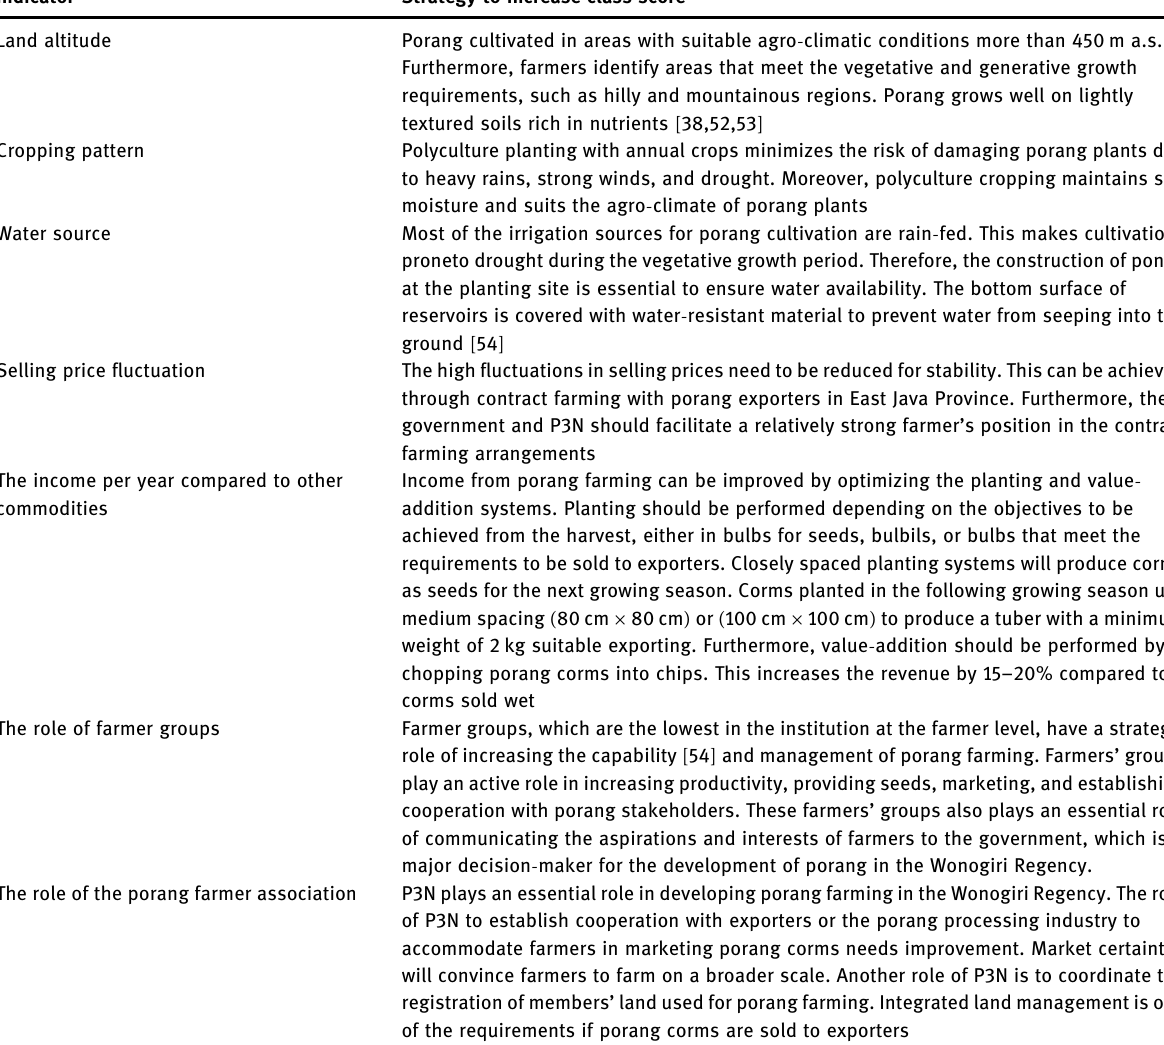
Table 4: Strategy for increasing the sustainability of “ Porang ” ( A. muelleri Blume ) farming in supporting triple export movement policy